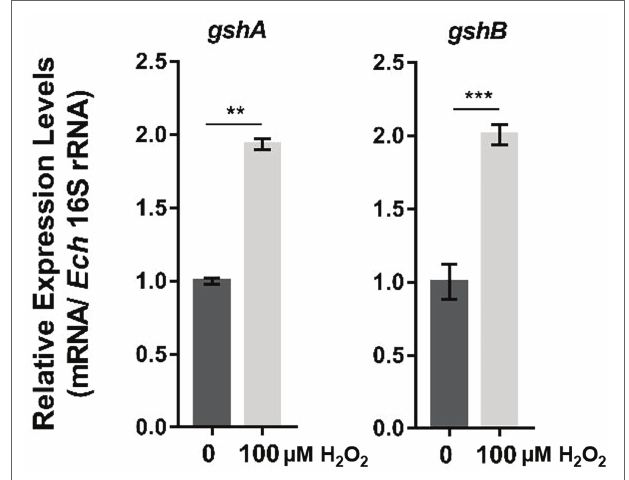
FIGURE 1 | The expression of gshA and gshB is upregulated upon oxidative stress. At 36 h p.i. synchronously E. chaffeensis -infected THP-1 cells were treated with H 2 O 2 at a final concentration of 100 μ M or culture medium (CTL) at 37 ° C for 2 h. The expression levels of gshA and gshB were determined with qRT-PCR and normalized against those of E. chaffeensis 16S rRNA. The value of gshA or gshB in CTL sample is as 1, respectively. Relative values to the amount in CTL sample are shown. Data indicate means ± standard deviations ( n = 3). The significant differences are represented by p -values determined with Student’s t -test (** p < 0.01, *** p <